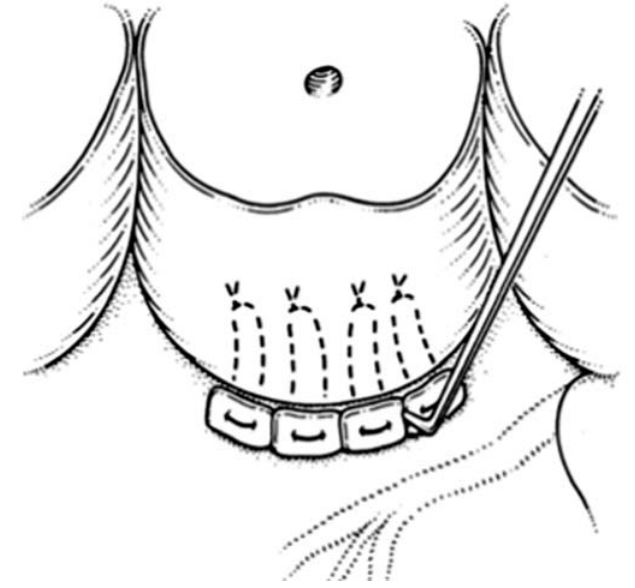
Figure 6. Cartoon depicting the final repair with the sutures tied down causing obliteration of the ventricular septal defect and plication of the right coronary aortic sinus. (With permission J Thorac Cardiovasc Surg